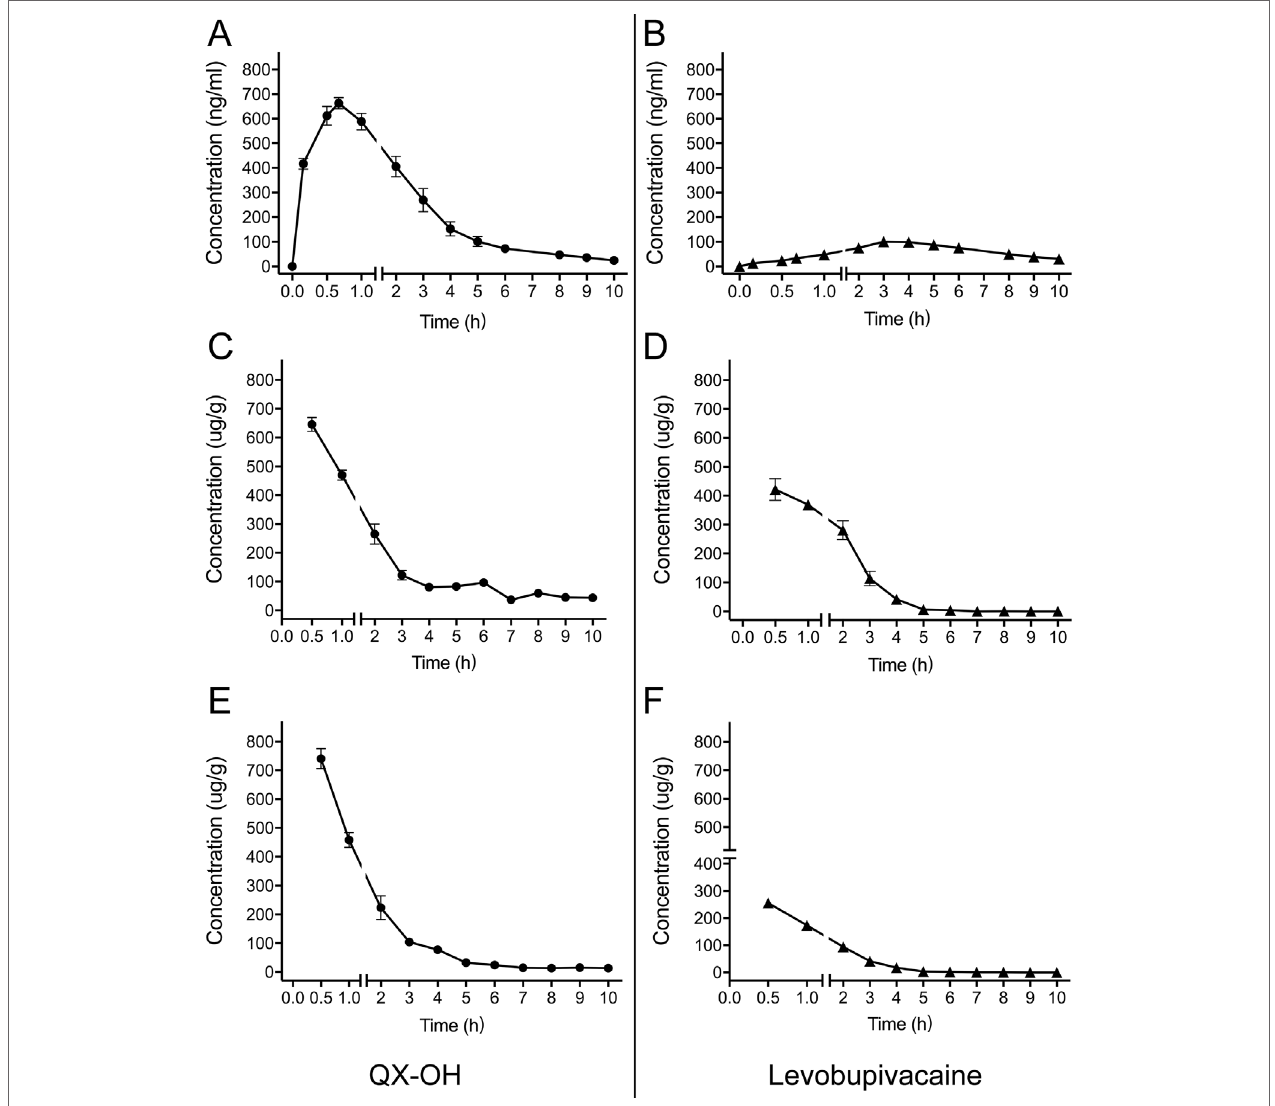
FIGURE 1 | Mean concentration-time profiles of LL-1 in plasma (A–B) , sciatic nerve ( C – D ) and muscle (E–F) after sciatic nerve block in rats. (n = 10 for plasma, and n = 5 per time point for muscle and sciatic nerve). Data are expressed as mean ± SEM. Levo-Bupi, levobupivacaine; LL-1, 35 mM QX-OH/10 mM Levo-Bupi.